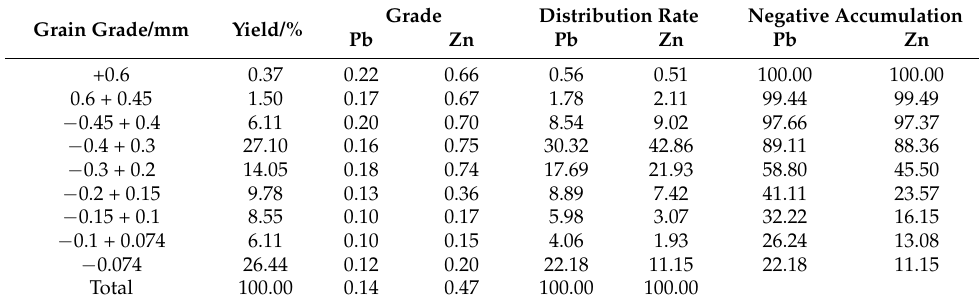
Table 6. Results of particle size analysis of coarse-grain mixed flotation